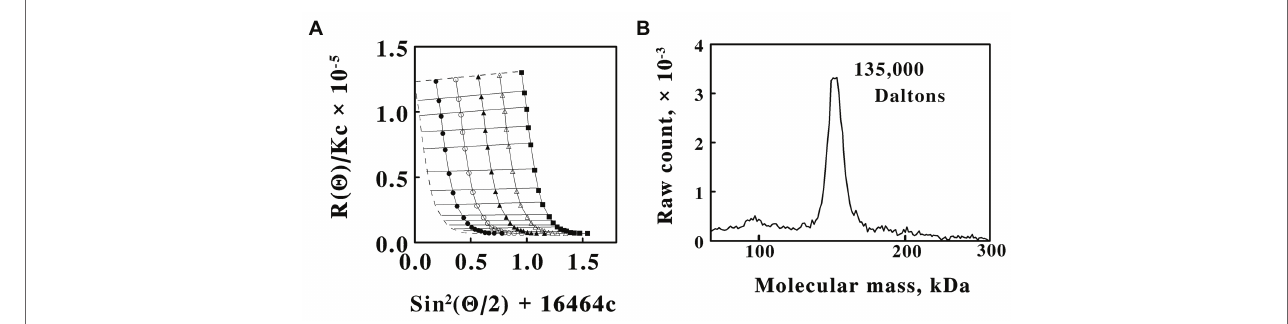
FIGURE 4 | Size analyses of the native cytochrome 579 purified from cell-free extracts of L. ferriphilum . (A) A Debye plot constructed from static light scattering measurements at different angles and concentrations of purified protein n 0.01 N sulfuric acid. Protein concentrations in μ g/ml: 1.15, closed circles ; 2.31, open circles ; 3.46, closed triangles ; 4.62, open triangles ; and 5.77, closed squares . R ( Ø ) is the excess Rayleigh ratio, Ø is the angle between the incident and the scattered light, K is an instrument constant that is determined independently, c is the concentration of cytochrome 579, and 16,464 is an arbitrary constant that permitted an appropriate spread of the data for plotting and visualizing the results. Each datum represents the mean of at least eight determinations. The concentration variations and the angular data were fit with first and second order polynomials, respectively. The dashed lines represent extrapolation to zero angle ( horizontal line ) and zero concentration ( vertical curve ), respectively. (B) Macroion mobility spectrum of purified cytochrome 579 conducted at 320 ng/ml. The spectrum consisted of the accumulated counts of 10 repeat scans of 300 s